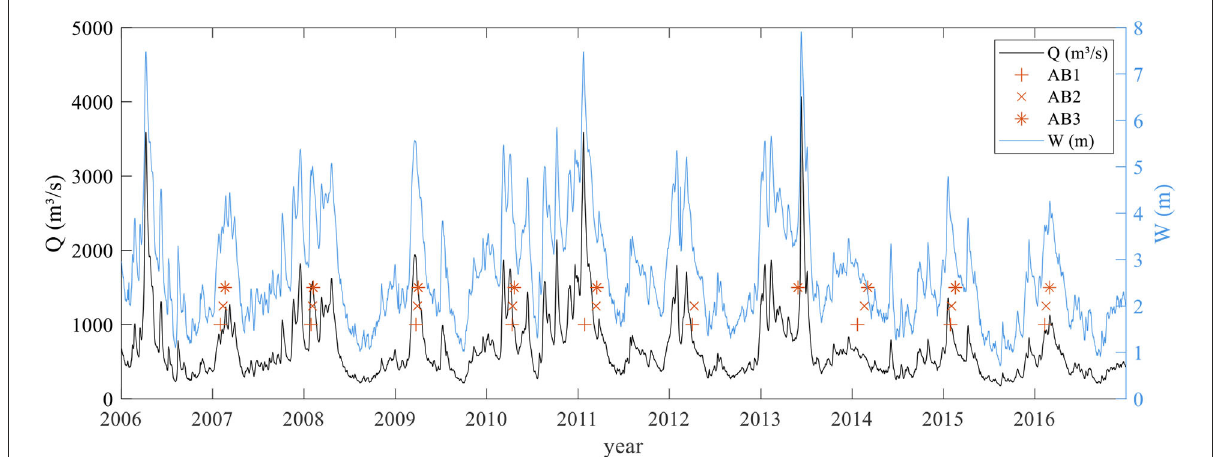
FIGURE3 Discharge and water stage measured at the gauging station “Neu Darchau” in the years 2006–2016. Discharges are indicated by the black line, water levels by the blue line and the dates of the first echo sounder survey in the investigated sections AB1, AB2 and AB3 are marked by red crosses, x-symbols and asterisks, respectively.